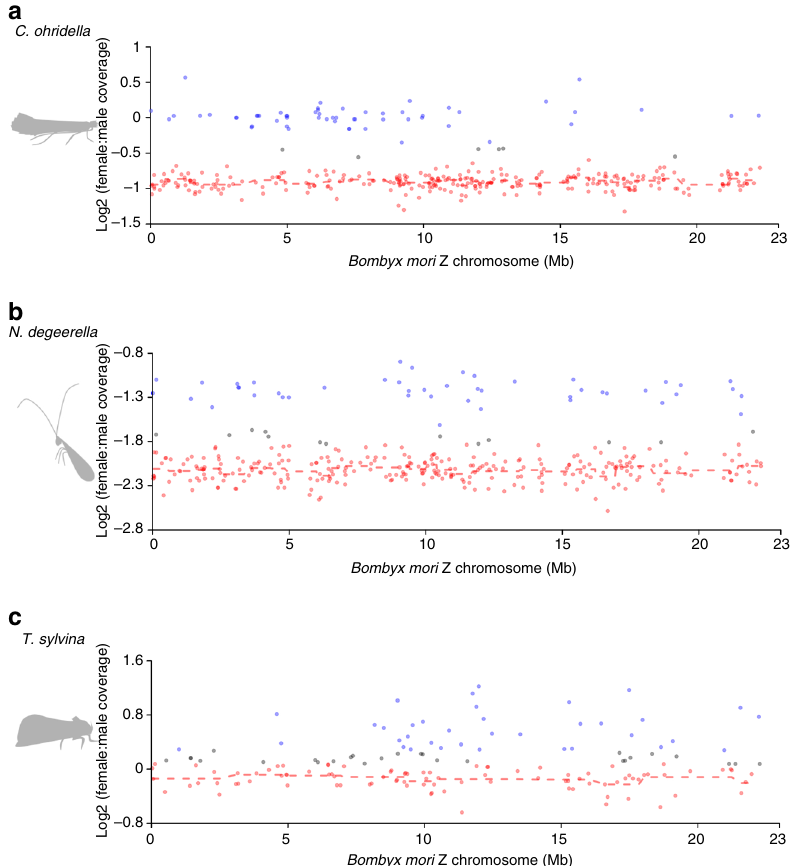
Fig. 3 Homology between the Z chromosome of B. mori and that of the other species. For each species, scaffolds mapping to the Z chromosome of B. mori (Chr. 1) have been classi fi ed as Z-linked (in red), autosomal (in blue), or unclassi fi ed (in gray). The Log2 of the female to male coverage ratio along the B. mori Z chromosome (Chr. 1) is shown for a C. ohridella , b N. degeerella , and c T. sylvina . Dashed lines are moving average based on sliding windows of 10